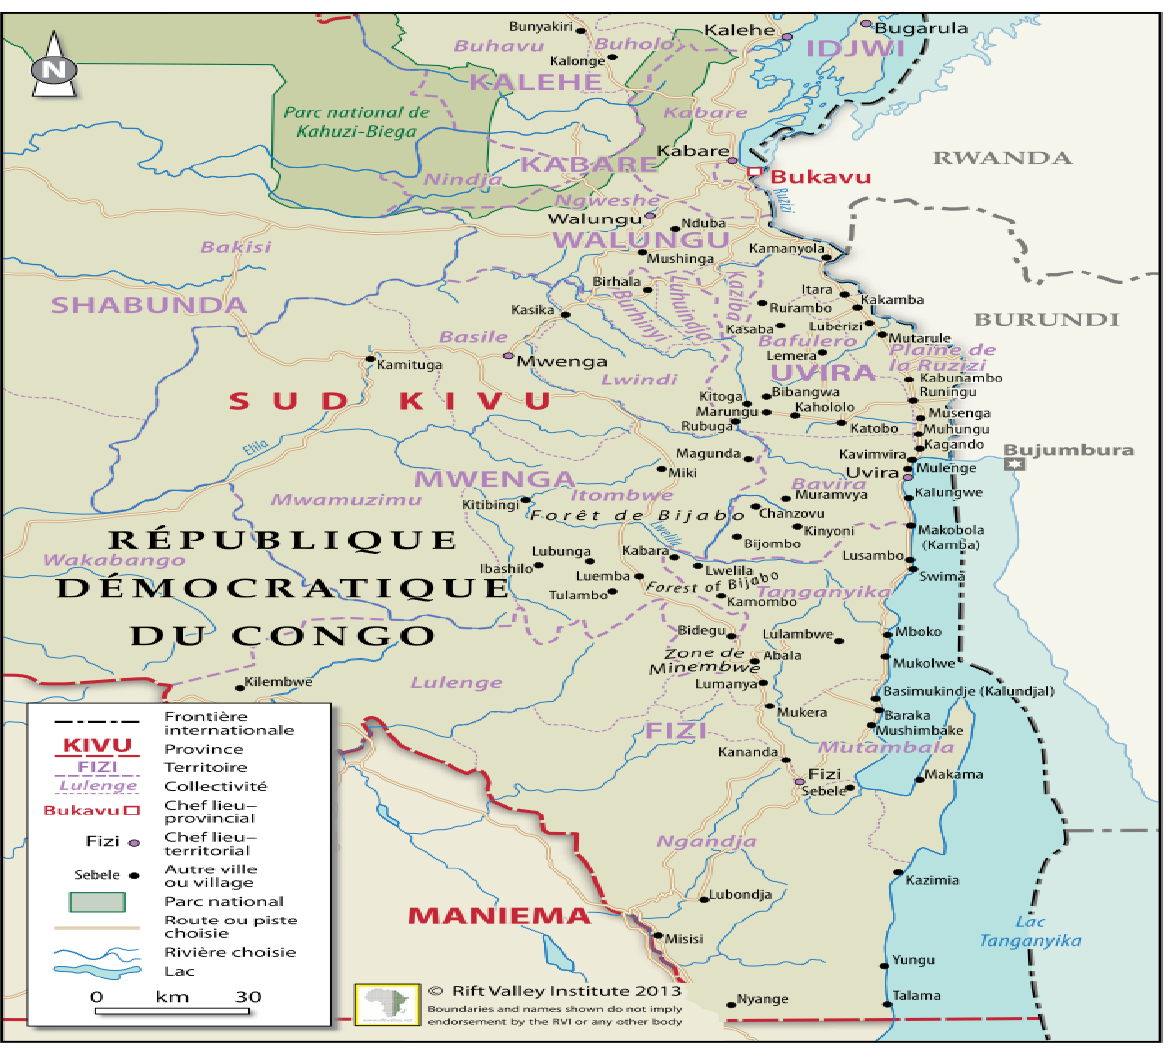
Figure 0B: A map of South-Kivu Province Showing the territories (Kabare, Kalehe) where study sites were selected across the different potato growing